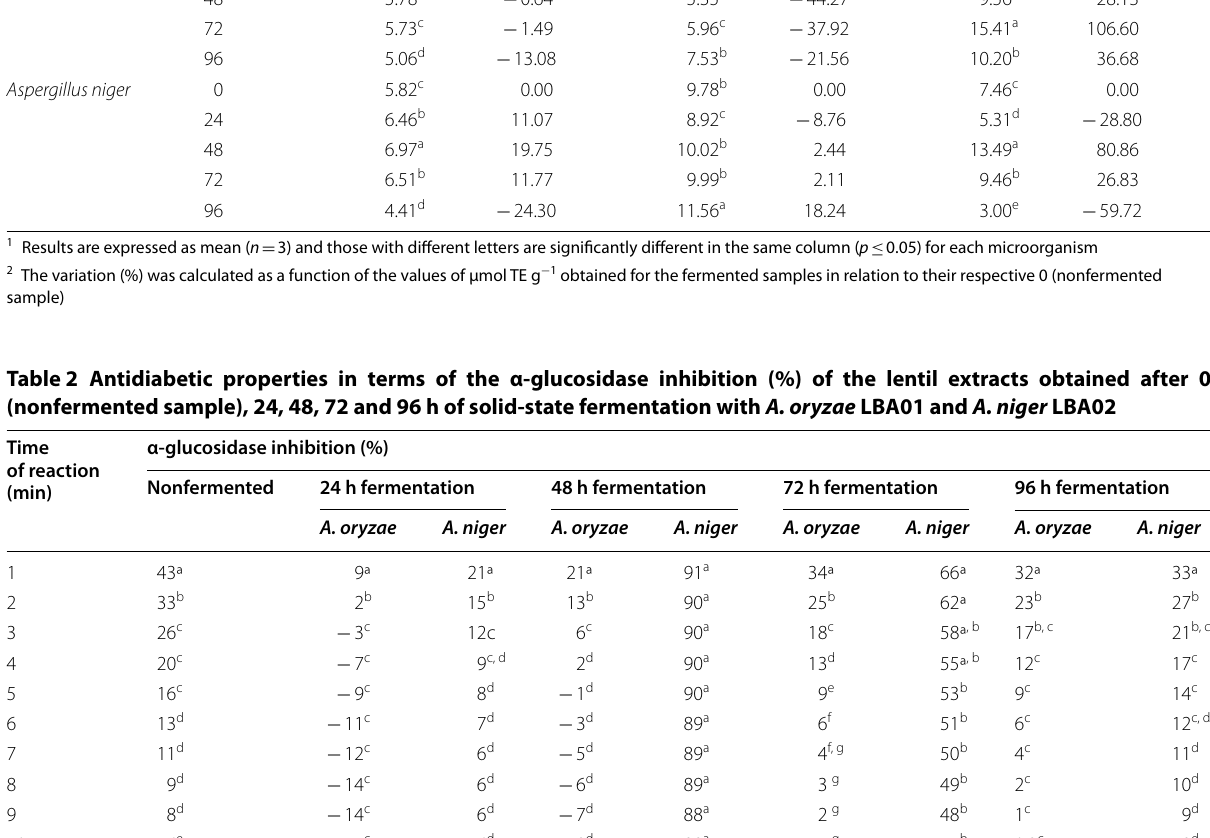
3) and those with different letters are significantly different on the same column with p =